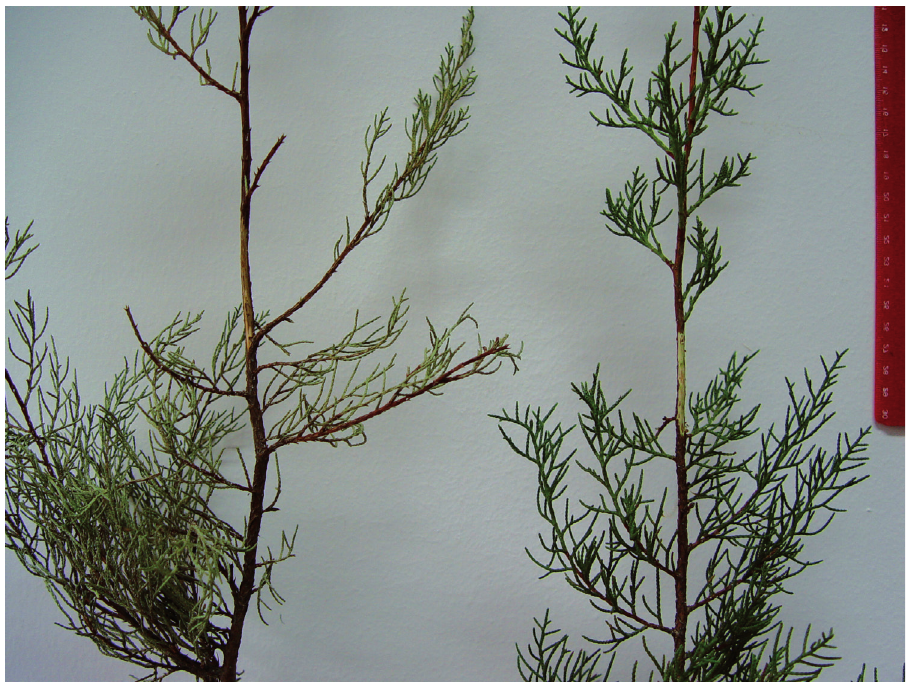
Figure 5. Phoenicean juniper sapling showing crown dieback symptoms and inner bark necrosis in the stem, 60 days after inoculation with Diplodia africana (left). Asymptomatic control seedling